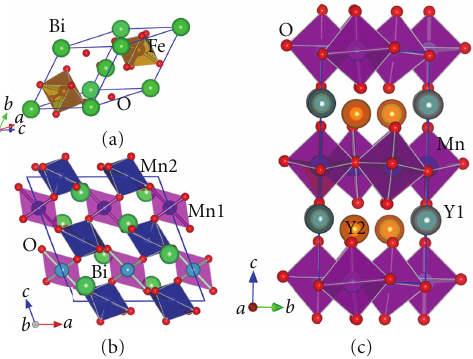
Figure 1: Schematic crystal structures of (a) BiFeO 3 with rhombo- hedral R3c symmetry, (b) BiMnO 3 with monoclinic C2/c symmetry, and (c) YMnO 3 with hexagonal P6 3 cm